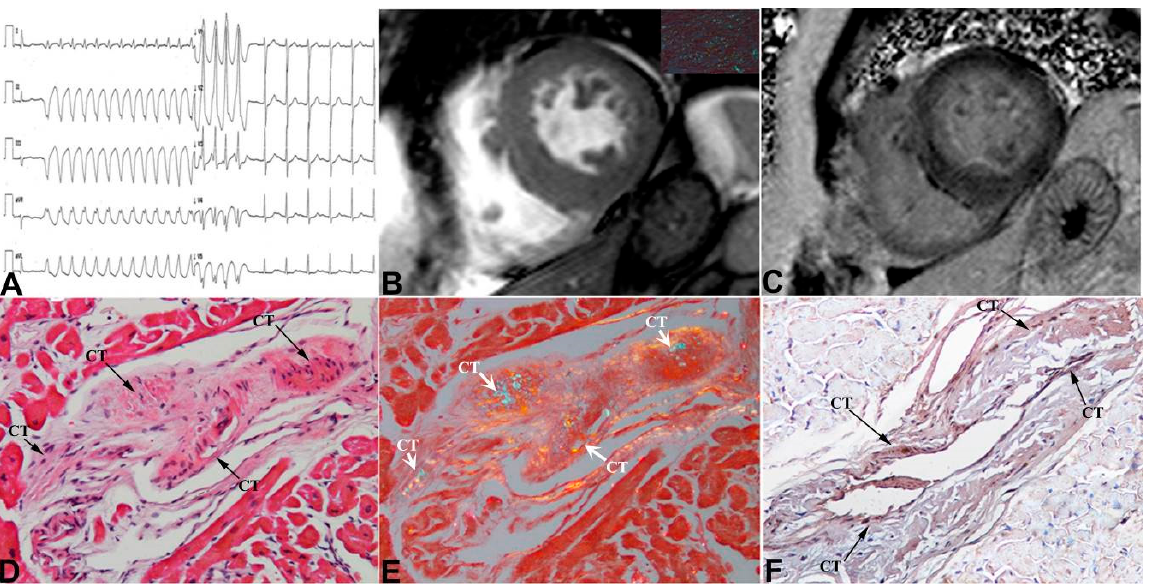
Figure 3. Moderate infiltration of CT in cardiac amyloid. Recurrent non-sustained ventricular tachycardia ( panel ( A )) is associated with moderate LV symmetric hypertrophy at CMR ( panel ( B ), MWT 17 mm), thickening of right ventricular free wall and “diffuse“ LGE pattern ( panel ( C )). Apple-green birefringent material at polarized light of Congo Red-stained myocardial sections is visible in insert in panel ( B ). Moderate infiltration of CT (arrows, panel ( D ) hematoxylin and eosin, ( E ) Congo Red staining, ( F ) immunohistochemistry for HCN4, 400 × magnification). CT = conduction tissue.